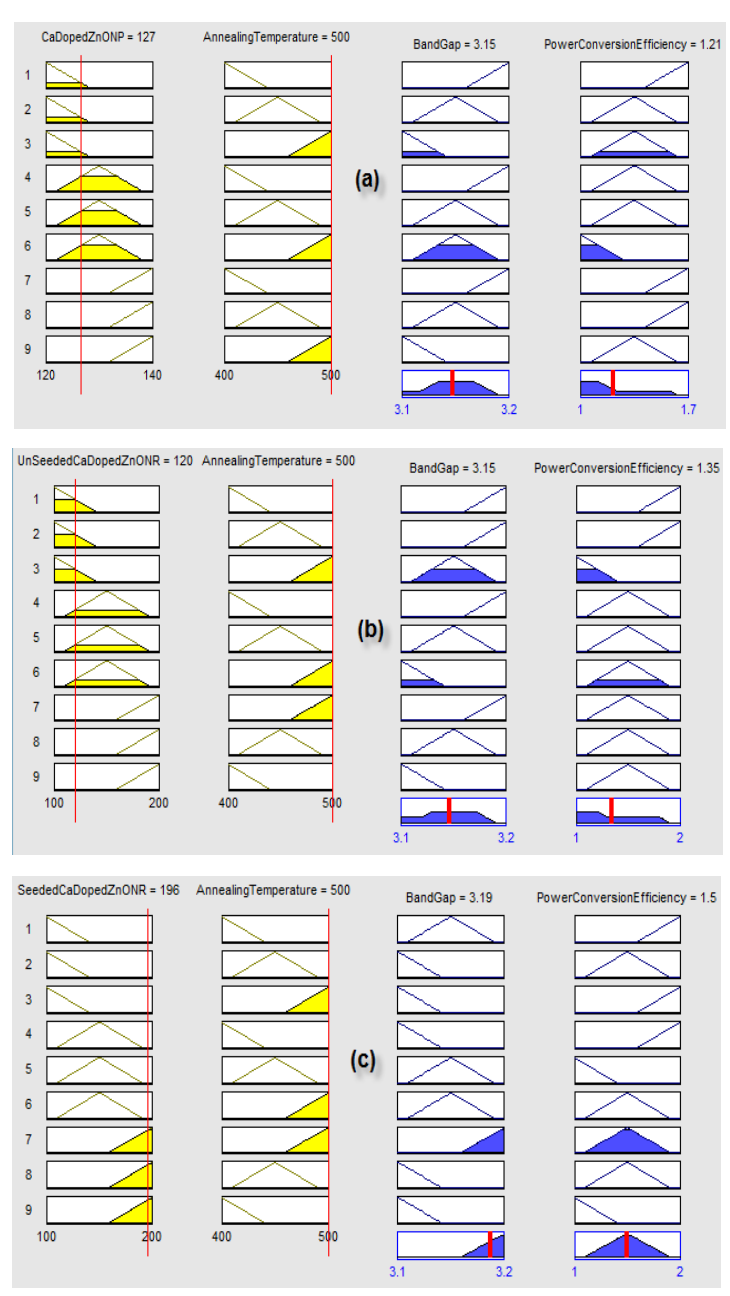
Figure 4. Rule Viewer: ( a ) Ca-doped ZnO NP; ( b ) Unseeded Ca-doped ZnO NR; ( c ) Seeded Ca-doped ZnO NR .